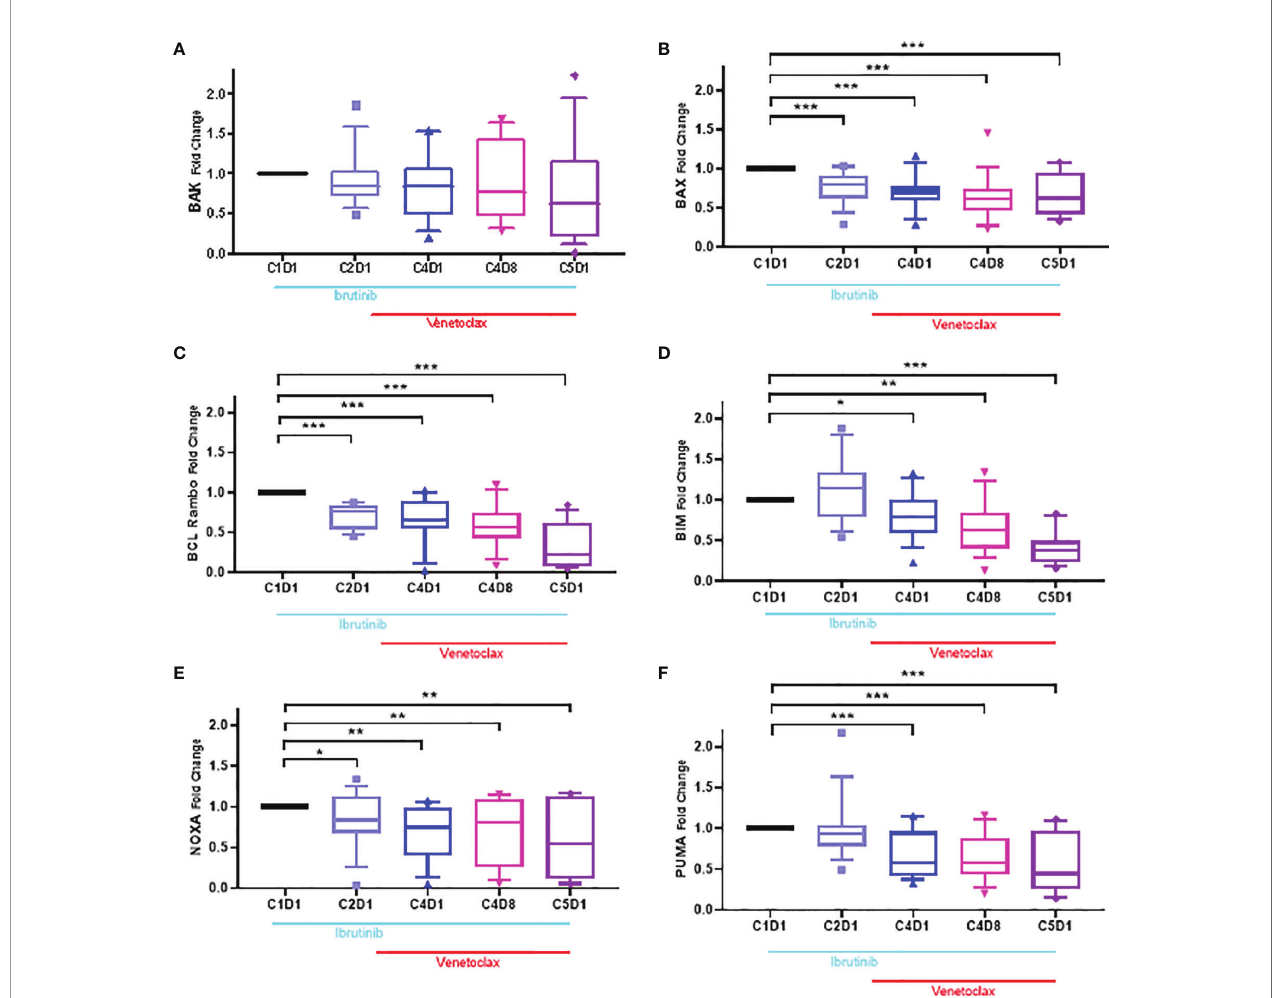
FIGURE 6 | Box plots for changes in the level of Bcl-2 proapoptotic proteins during ibrutinib monotherapy or ibrutinib plus venetoclax therapy. PBMCs from 13 to 15 patients were obtained at indicated times during therapy. Proteins were extracted and immunoblots were performed for BAK (A), BAX (B) ; Bcl-Rambo (C) Bim (D); NOXA (E) and PUMA (F) . Protein levels were quantitated and normalized with GAPDH and compared with the levels at baseline (C1D1). Each box and whiskers represent 10 to 90 percentile and horizontal lines are median values. C, cycle and D, days. Statistical signi fi cance between any time points and baseline values is provided. * ≤ 0.05; ** ≤ 0.001; *** ≤ 0.0001.